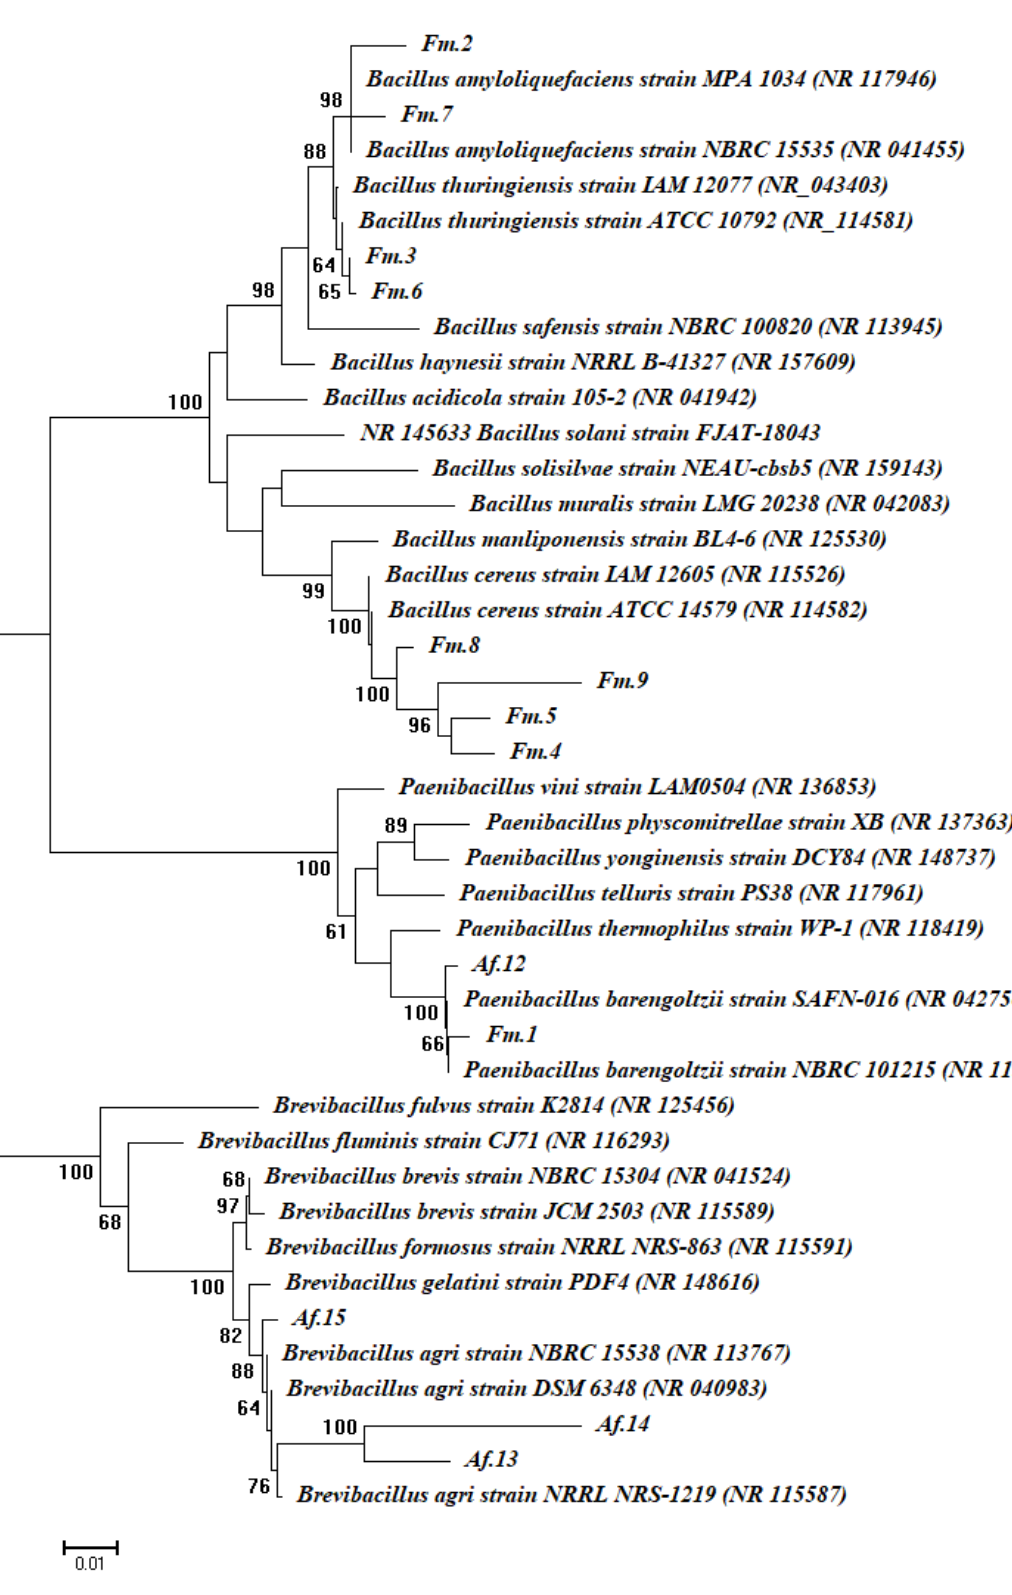
Figure 2. Phylogenetic analysis of 16S rRNA sequences of bacterial strains with reference sequences from NCBI. Fm.1–Fm.9 refers to 16S rRNA sequences of bacteria isolated from Fagonia mollis plants, whereas Af.13–Af.15 are the sequences from isolates from Achillea fragrantissima . Identity of the bacterial isolates is available in Table 2. The analysis was performed in MEGA 6 using the neighbor-joining method.